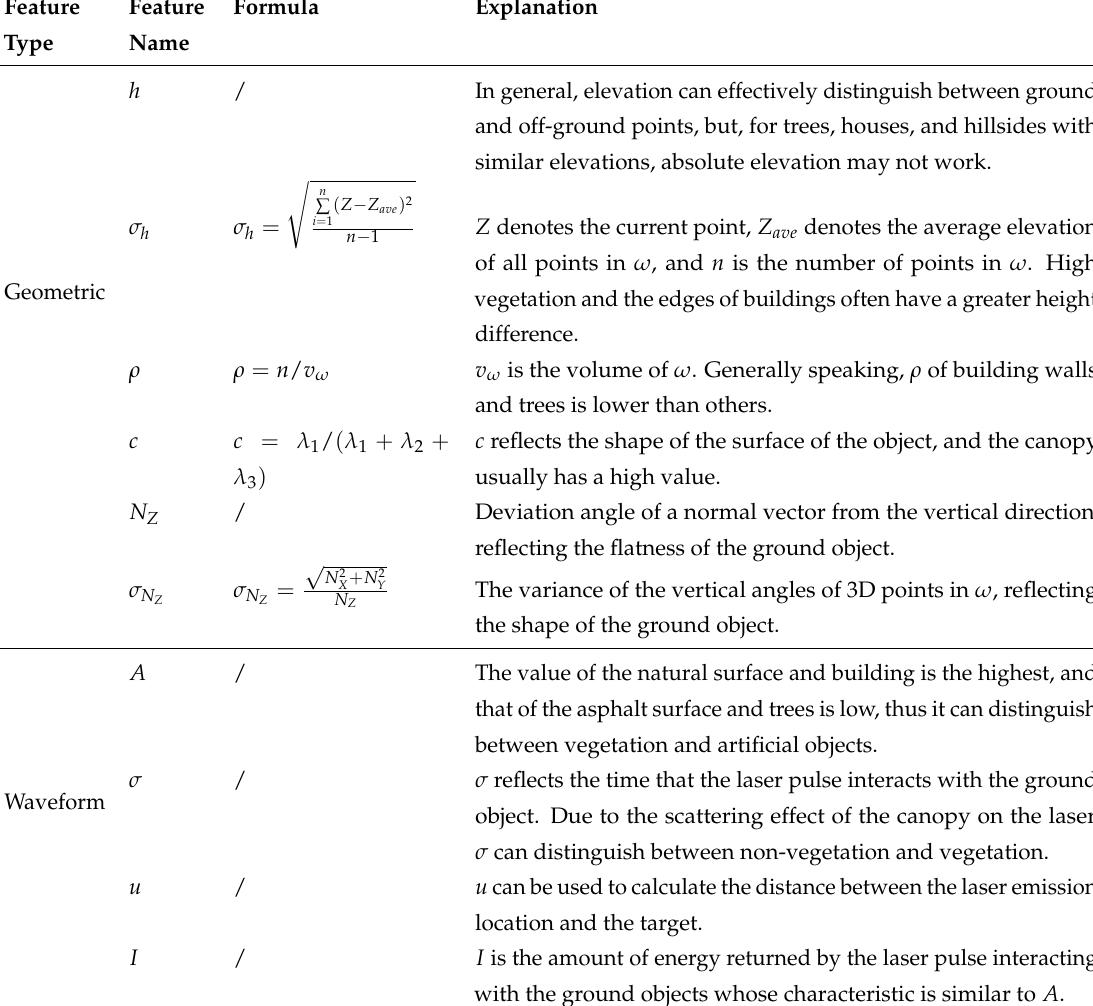
Table 1. Features for